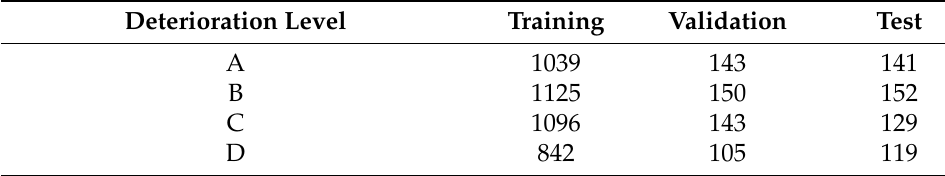
Table 2. Numbers of the distress images of efflorescence used in the